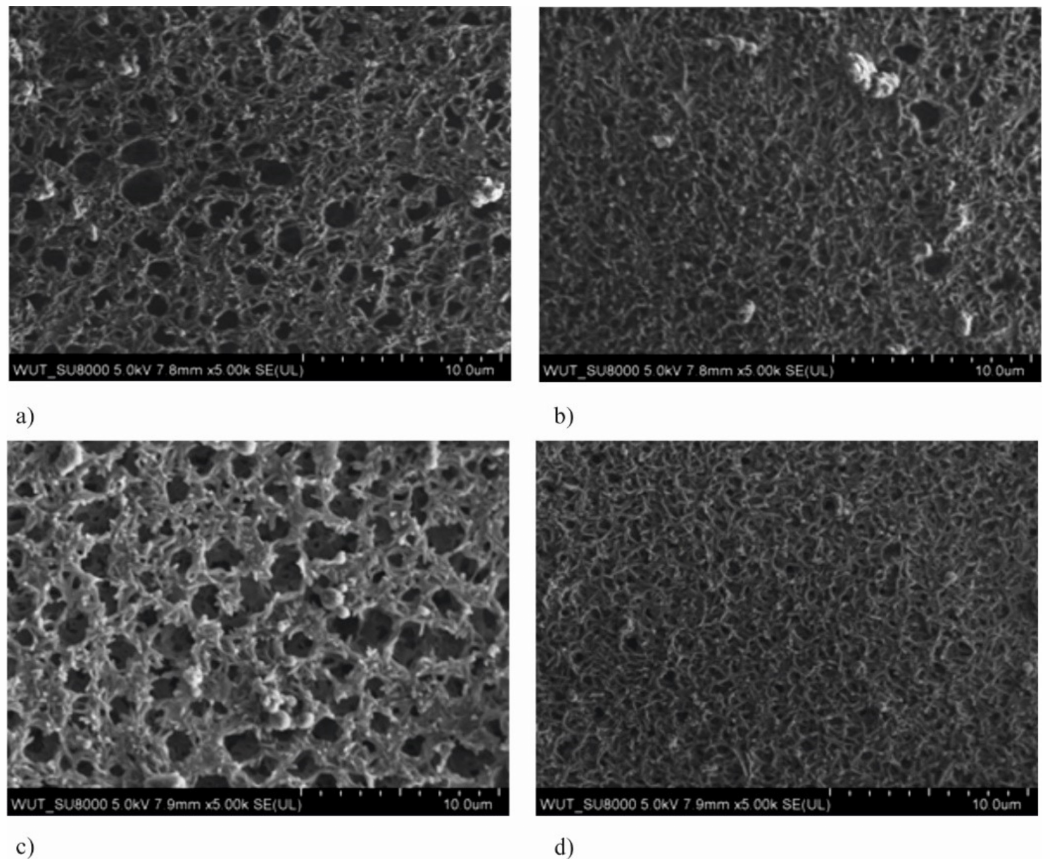
Figure 1. SEM images of the membranes with TiO 2 + CuO coatings deposited at different magnetron powers PM in two characteristic areas with different pore sizes, ( a ) P M-Cu = 15 W, P M-Ti = 650 W, t = 30 s, area with a high propor- tion of large spherical pores, ( b ) P M-Cu = 15 W, P M-Ti = 650 W, t = 30 s, area with a high proportion of small irregular pores ( c ) P M-Cu = 15 W, P M-Ti = 1000 W, t = 30 s area with a high proportion of large spherical pores, ( d ) P M-Cu = 15 W, P M-Ti = 1000 W, t = 30 s area with a high proportion of small irregular